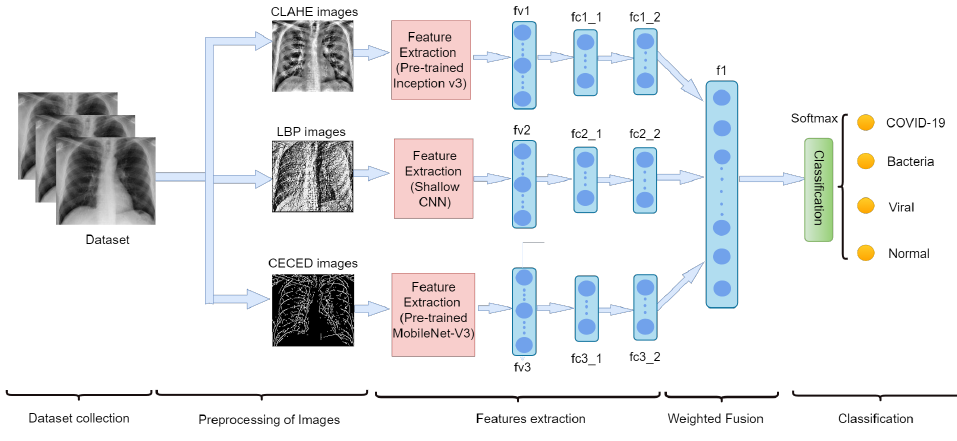
Figure 8. Our proposed multi-channel scheme for pneumonia